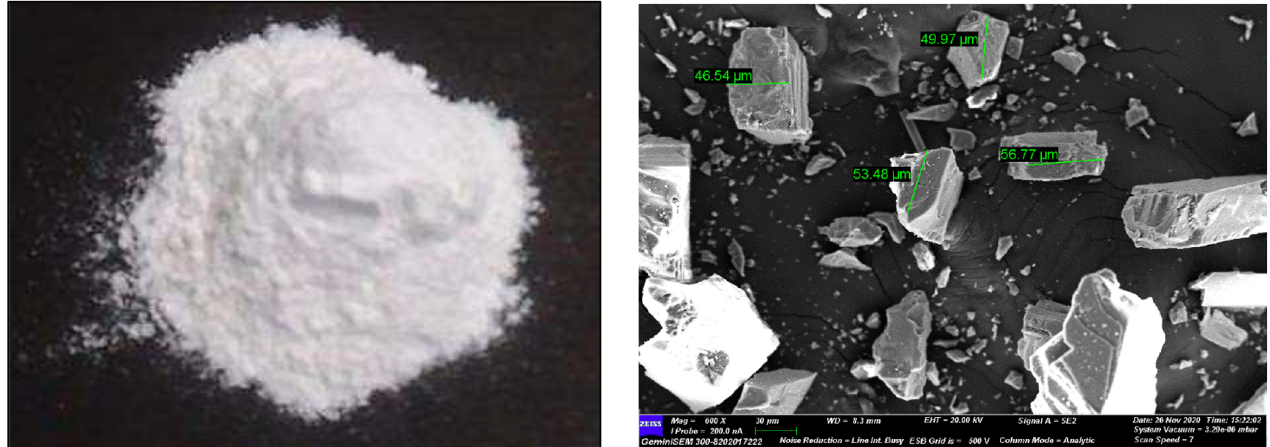
Fig. 2. Macro graph and SEM image of h-BN particles.